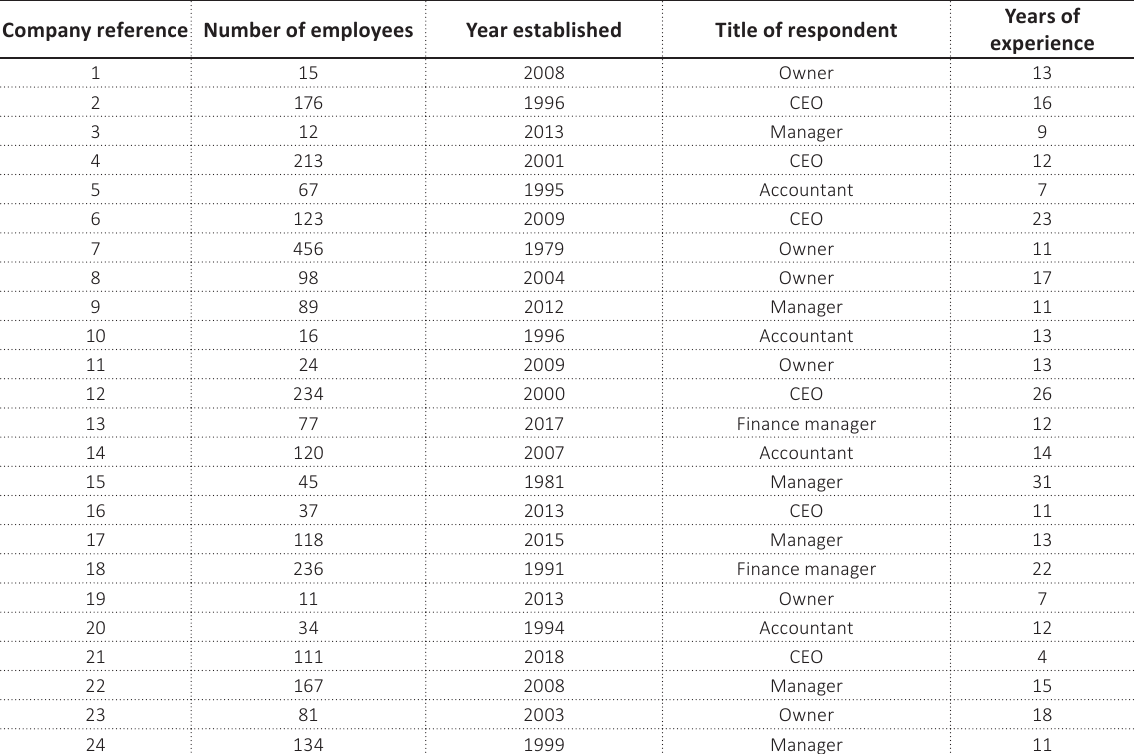
Table 1. Features of engaged SMEs and